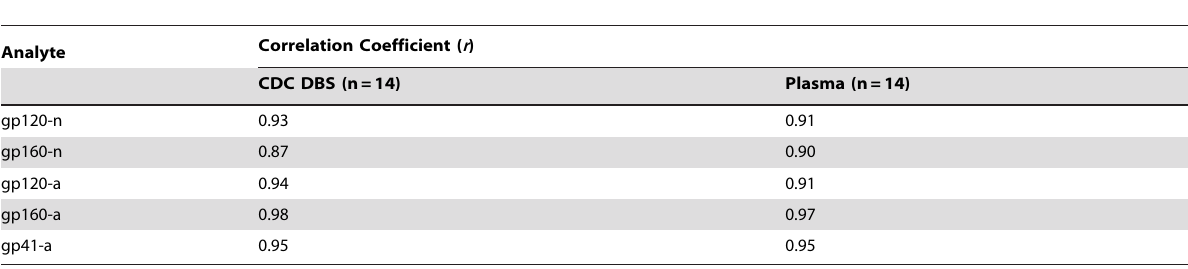
Table 3. Correlation with site-prepared